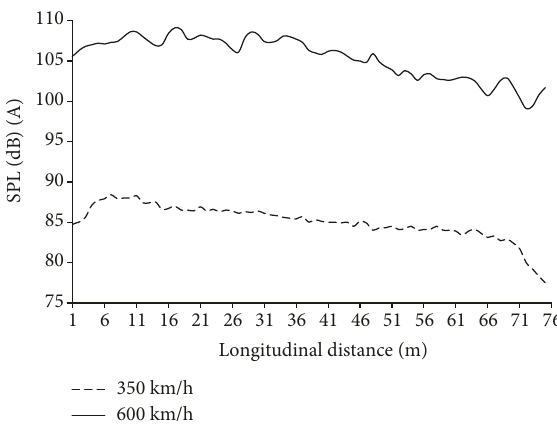
Figure 15: Comparison of sound pressure levels at longitudinal points with di ff erent